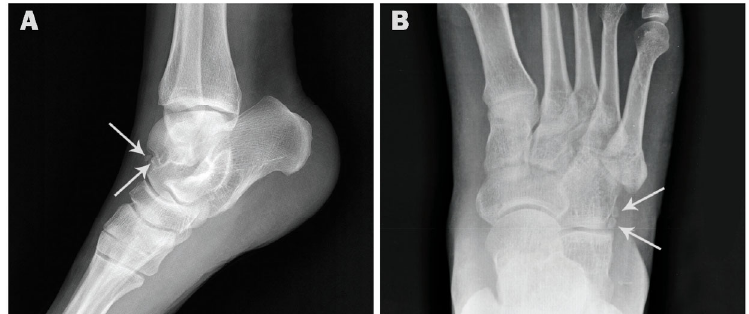
Figure 5. Radiographs showing bipartite ossicles (arrows). ( A ). Lateral radiograph showing bipartite supratalare in a 44-year-old female. ( B ). AP radiograph showing bipartite os peroneum in 50-year- old male. Kappa statistics on interobserver agreement are shown in Table 2. Interobserver agreement over identification of different accessory ossicles was almost perfect (kappa >